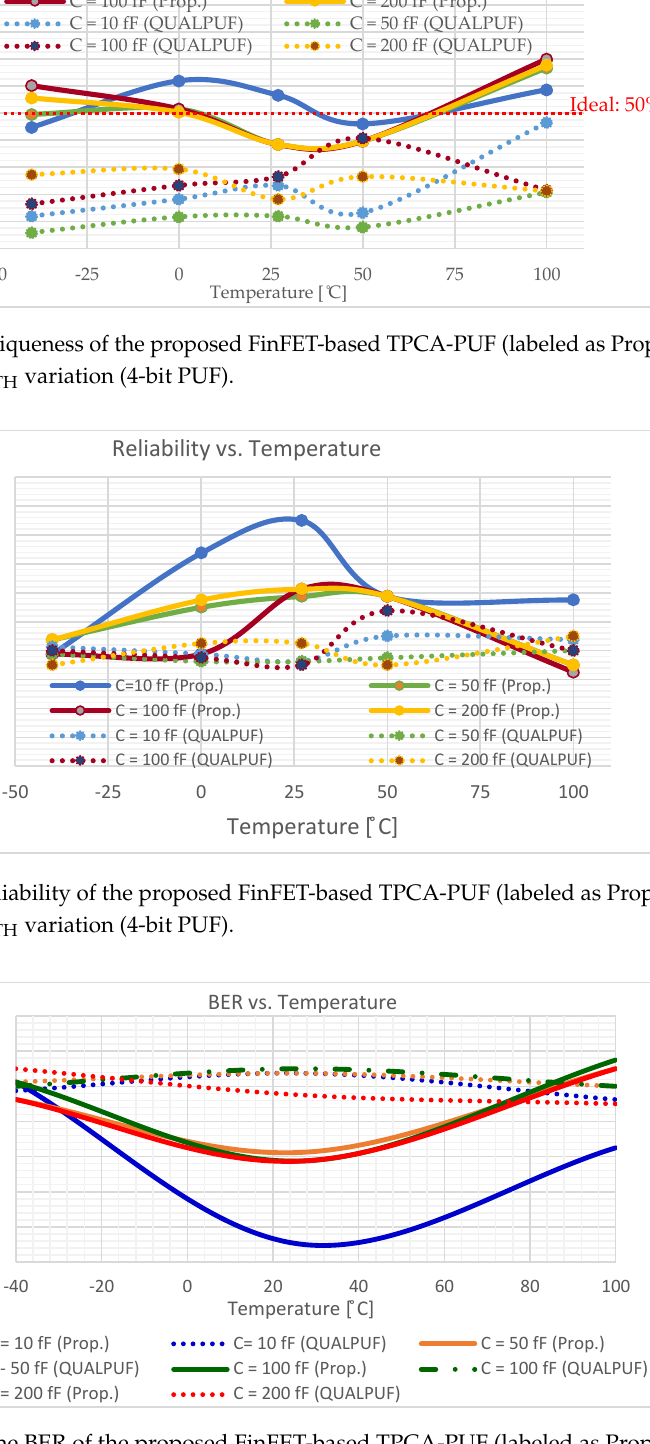
Figure 11. The BER of the proposed FinFET-based TPCA-PUF (labeled as Prop.) versus QUALPUF under the ±20% supply voltage variation (4-bit PUF).